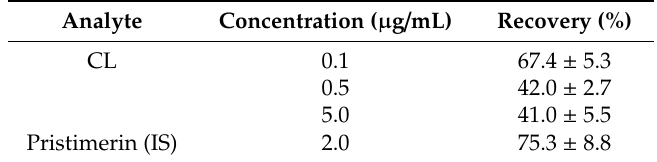
Table 4. Recovery of CL and internal standard (IS) from rat plasma (n =